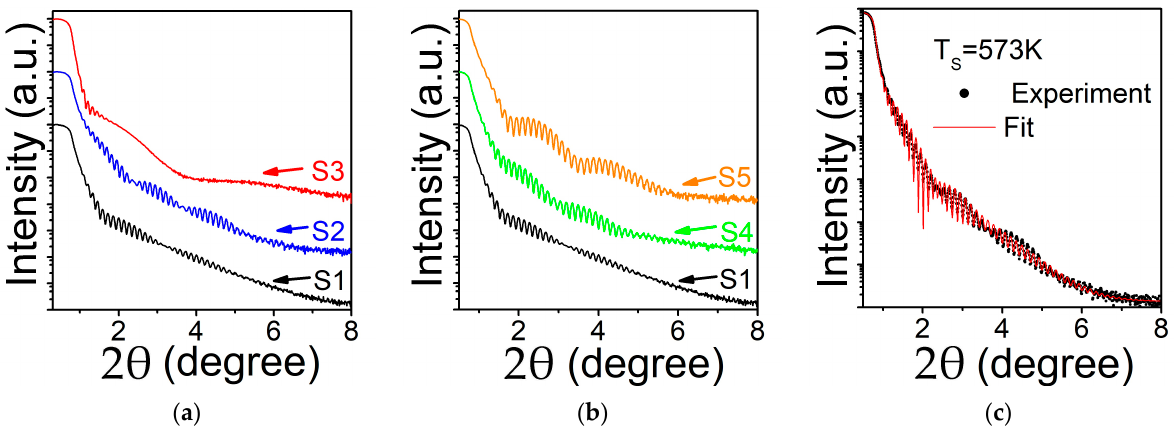
Figure 1. X-ray reflectivity for Co 2 FeGe films: ( a ) deposited at T S = RT (S1), T S = 573 K (S2), T S = 773 K (S3); ( b ) deposited at RT and annealed for 1 h at T a = 573 K (S4), T a = 773 K (S5); ( c ) fit of the experimental XRR spectrum for the film deposited at T S = 573 K. Fitting parameters are summarized in Table 1.